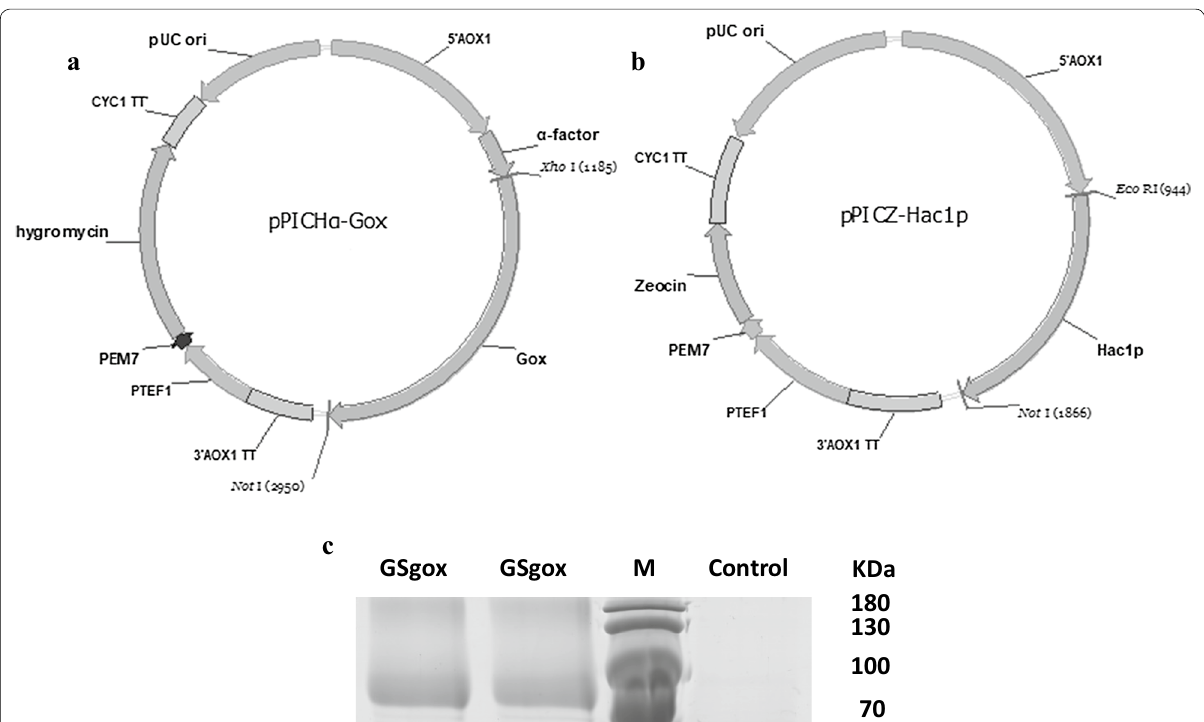
Fig. 1 Construction of recombinant strains and Gox expression. a The expression vector containing Gox (from Aspergillus niger ). b The expression vector containing Hac1p (from P. pastoris and H. sapiens ). c Gox expression analysis by